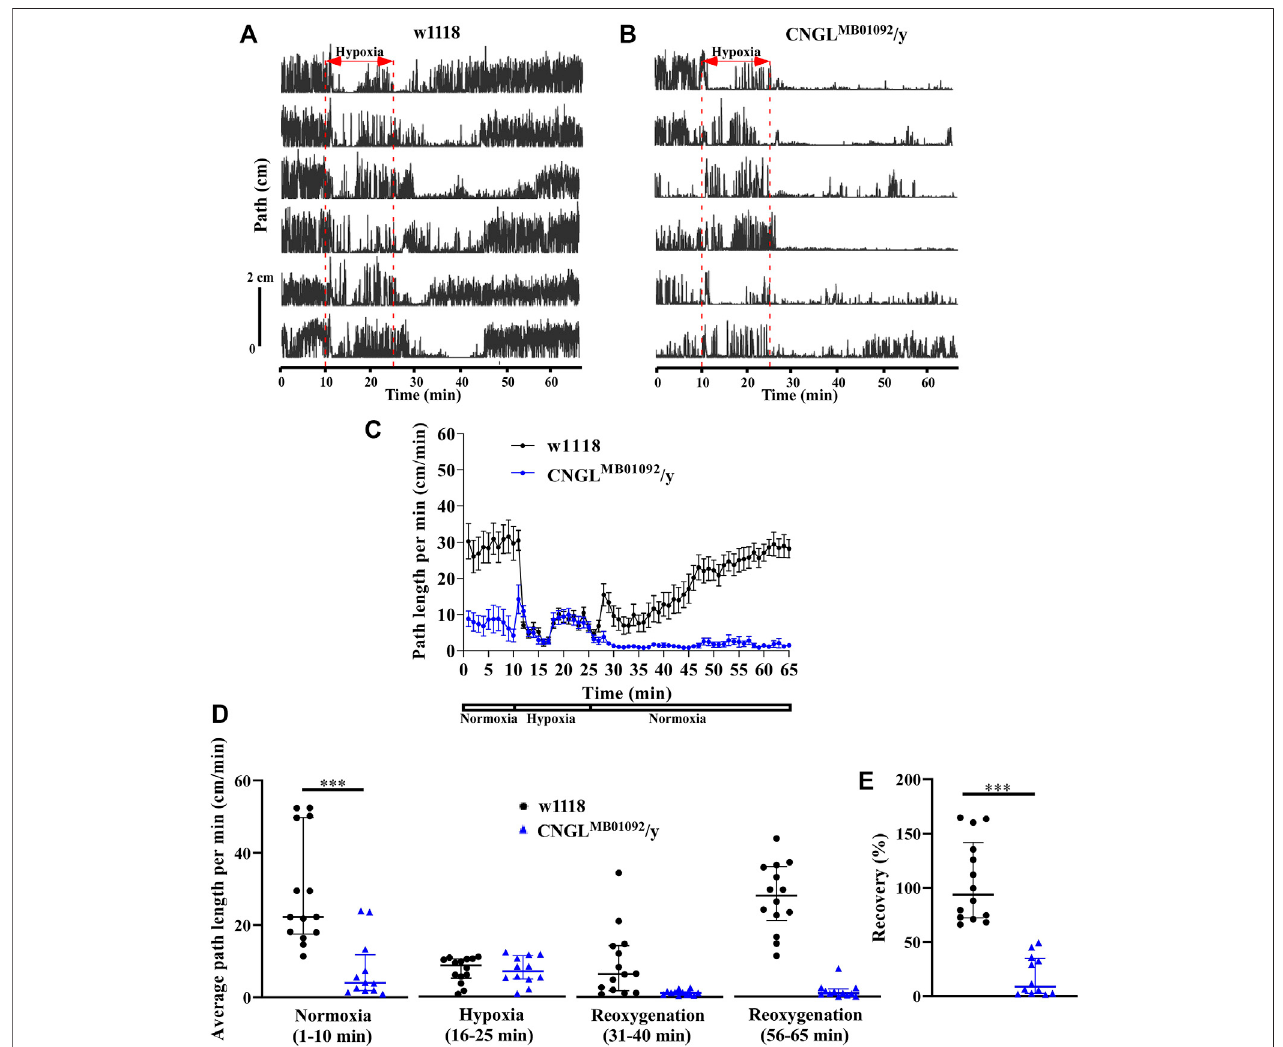
FIGURE2| ReducedlocomotoractivityundernormoxiaandreducedrecoveryinresponsetohypoxiainCNGL MB01092 /y fl ies. (A,B) Locomotoranalysisforw1118 fl ies and CNGL MB01092 /y fl ies with hypoxia. In thisand following fi gures, each tracerepresents locomotor activity ofa single fl y illustrated by plotting the distancethe fl y ’ s centre of mass moved in successive 0.2 s intervals (Path) against the time of occurrence. A 15 min hypoxia was applied after 10 min locomotor activity under normoxia. Flieswere then returned to normoxia and allowed to recover for 40 min. (C) Path length per minute ofcontrol fl ies (w1118) (black circles and black line, n = 14) and mutant fl y line CNGL MB01092 /y (blue circles and blue line, n = 12) under normoxia, during hypoxia and after hypoxia-treatment. (D) The average path length per minute under normoxia (1 – 10 min), during hypoxia (16 – 25 min), and during reoxygenation (31 – 40 min and 56 – 65 min) of w1118 and CNGL MB01092 /y fl ies. (E) The percent recovery of w1118 and CNGL MB01092 /y fl ies in response to hypoxia. Asterisks (***) indicate p < 0.001 by Mann-Whitney test.